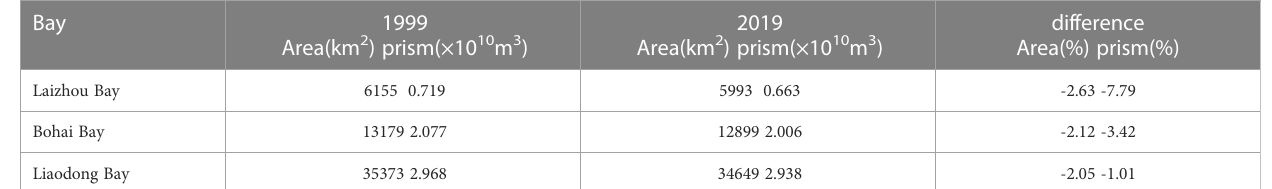
TABLE 3 Tidal prism and area of the